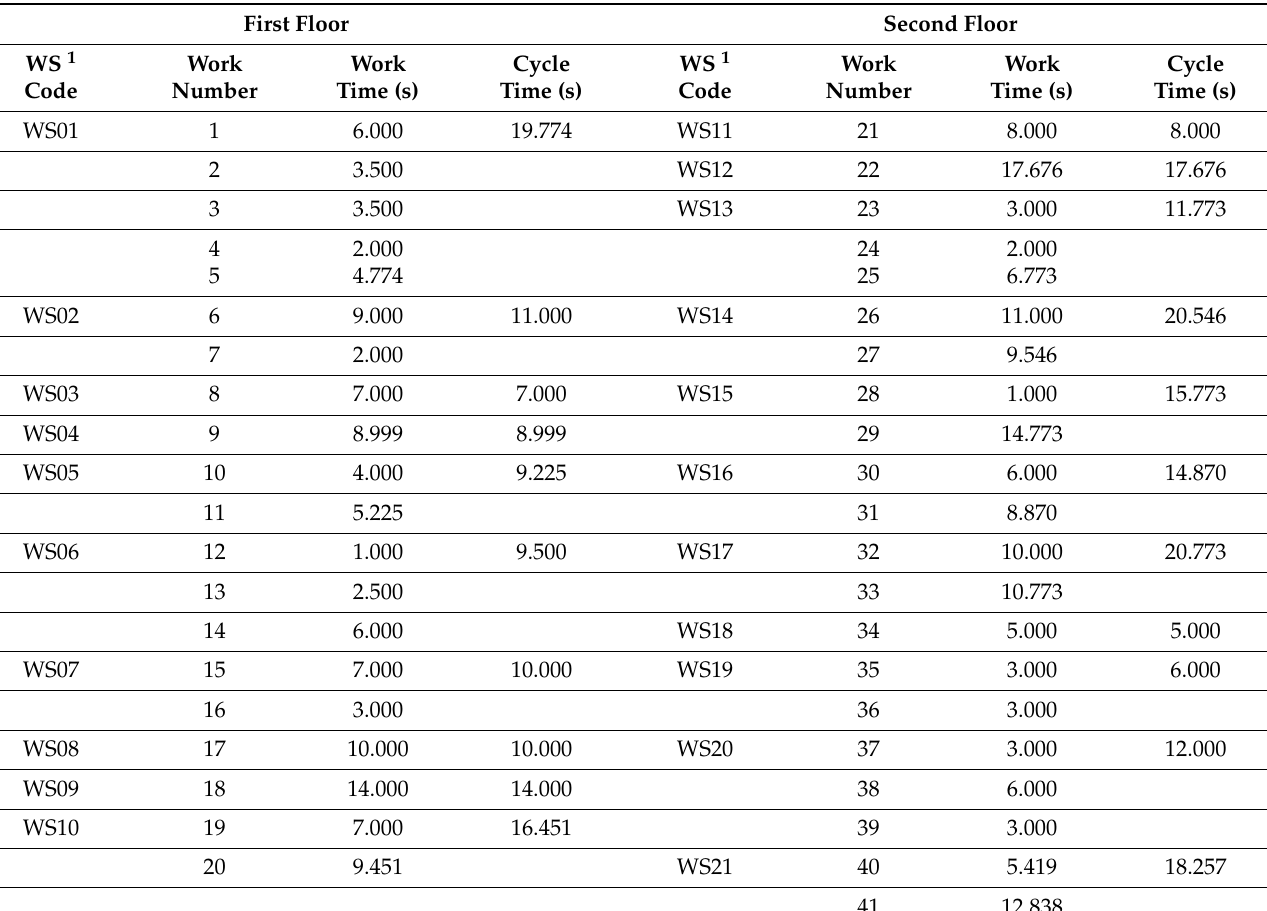
Table 3. Process and sequence information of the as-is